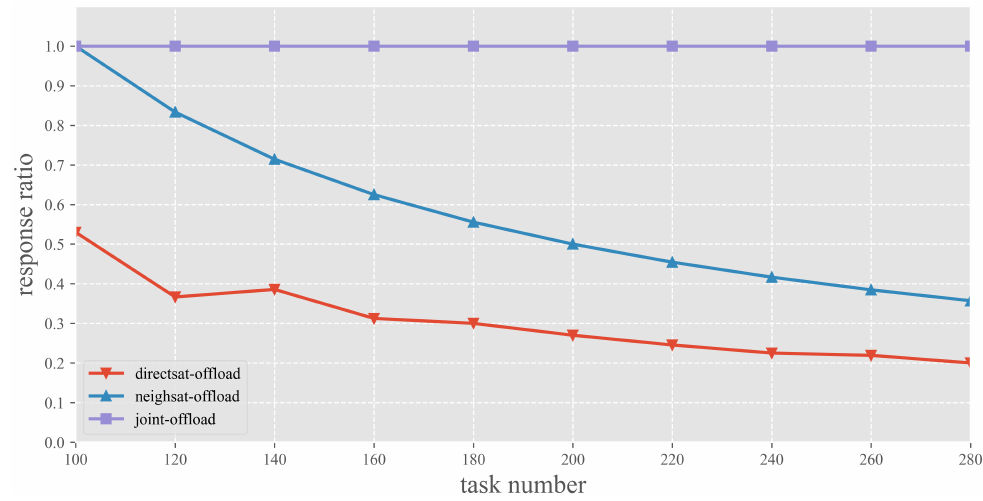
Figure 10. Task response rate varies with number of tasks in constellation 3 with 144 satellites.